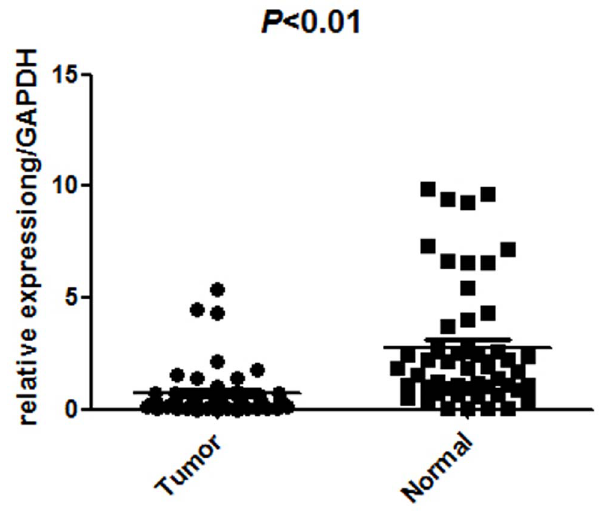
Figure 1. Decreased UPK1A mRNA expression in gastric cancer tumor tissues was detected by RT-qPCR (n=51, p , 0.01, gastric cancer tumor compared with adjacent non-tumor tissue, Wilcoxon matched-pairs signed-rank test). The small box inside the outside box represents the mean.